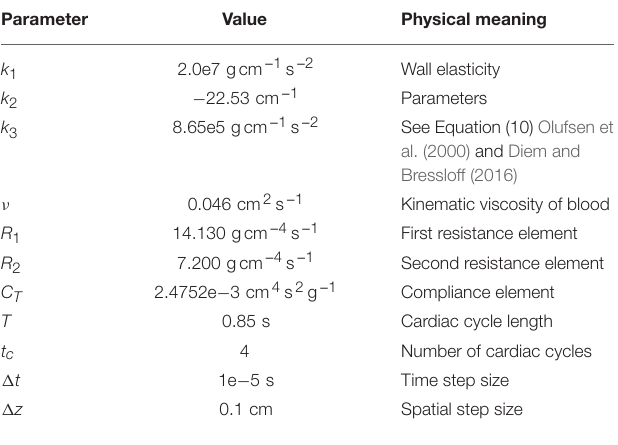
TABLE 2 | Simulation parameters for modeling a bifurcation of the MCA using VaMpy (Diem and Bressloff, 2016). Parameter Value